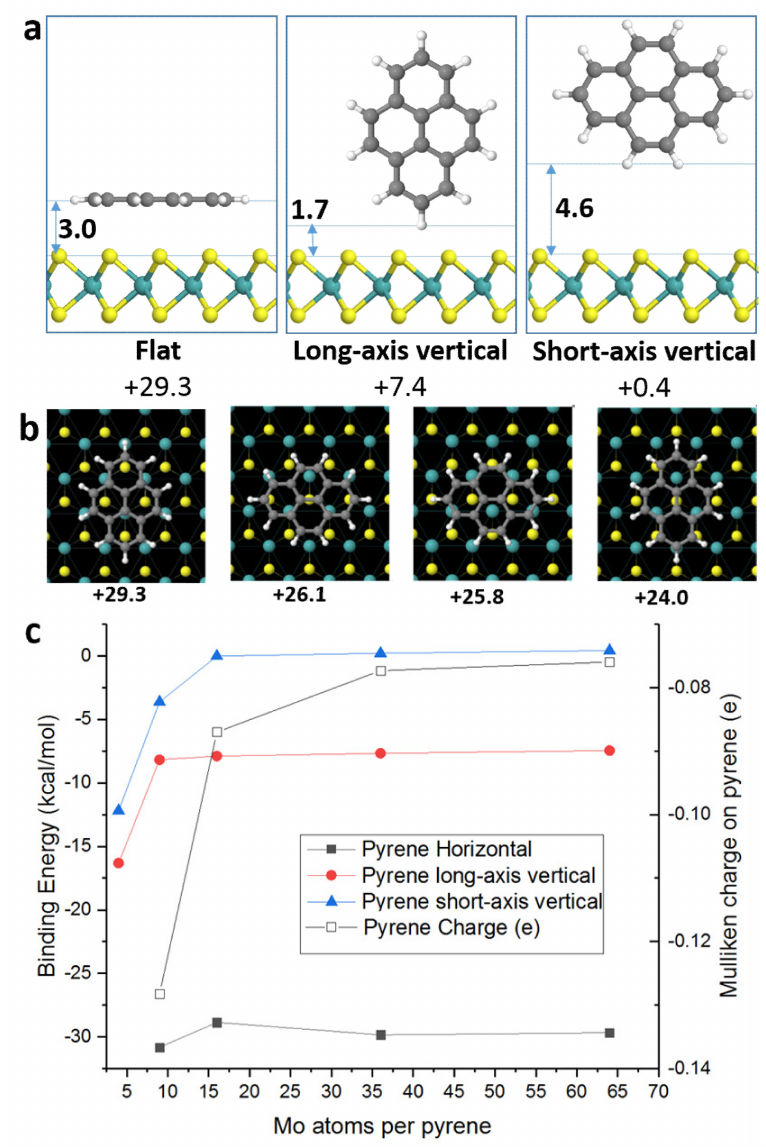
Figure 2. Density functional calculations of pyrene binding to 2H-MoS 2 showing ( a ) possible stacking orientations of pyrene (binding energies given in kcal / mol, pyrene / MoS 2 distances in Å), ( b ) variation in binding energy (kcal / mol) for pyrene in parallel-stacked configuration with surface translation. Atom species are Mo (cyan), S (yellow), C (gray), and H (white), and ( c ) variation in binding energy per molecule to MoS 2 surface for pyrene in di ff erent orientations, as a function of surface packing density (filled shapes), right-axis shows Mulliken charge of pyrene in the horizontal configuration (empty